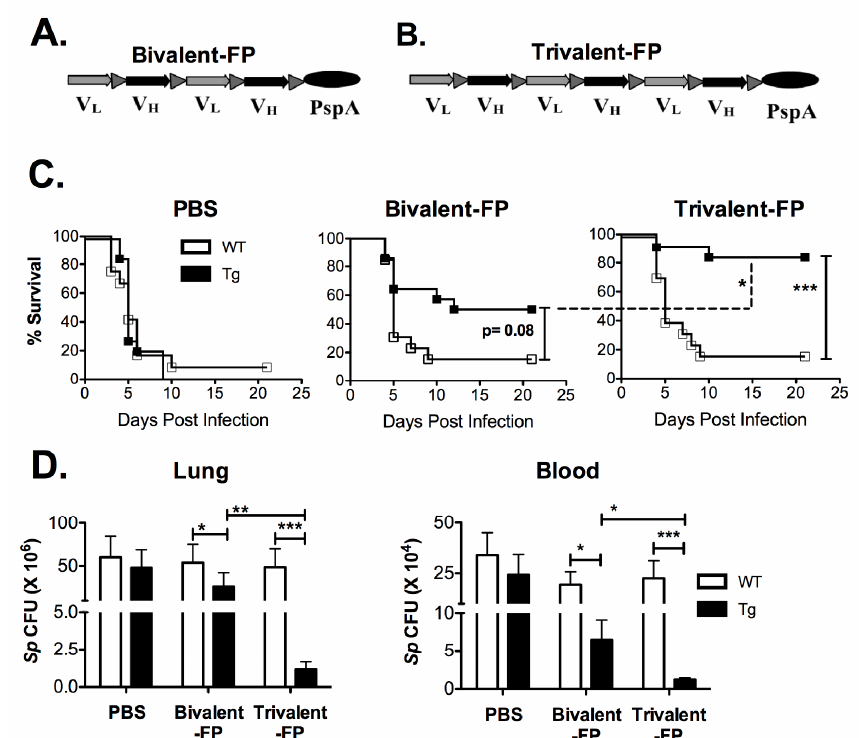
Figure 1. Trivalent-FP induced enhanced protection against pneumococcal infection compared to Bivalent-FP: ( A , B ) Schematic representation of the vaccines used in this study. Both vaccines contained a single chain variable fraction antibody (ScFv) and the antigen pneumococcal surface protein A (PspA). VL and VH represent the light and heavy chains of the ScFv, respectively. Bivalent-FP (A) contains two pairs of the ScFv, whereas Trivalent-FP (B) contains three pairs, and both have one copy of the antigen PspA. ( C , D ) Groups of WT (wild type) and Tg (transgenic) mice were immunized twice at an interval of 3 weeks with PBS, Bivalent-FP (208 pmol), or Trivalent-FP (208 pmol) via the intranasal route, and challenged with a lethal dose (2 × 10 6 CFUs) of Streptococcus pneumoniae at 2 weeks post-booster immunization. ( A ) Kaplan–Meier survival curve is presented; combined data from two independent experiments is shown ( n = 14 / group, *** p = 0.005). Statistical significance between indicated groups was evaluated by Mentel–Cox (log-rank) test. ( B ) Following immunization and challenge, bacterial burden ( Sp colony forming unit (CFU): S. pneumoniae CFU) in blood and lung homogenates was evaluated on day 4 post-infection. Mean ± SE of data from two independent experiments is shown ( n = 10 / group, * p = 0.05, ** p = 0.01, *** p = 0.005). Statistical significance between indicated groups was evaluated by Mann–Whitney nonparametric